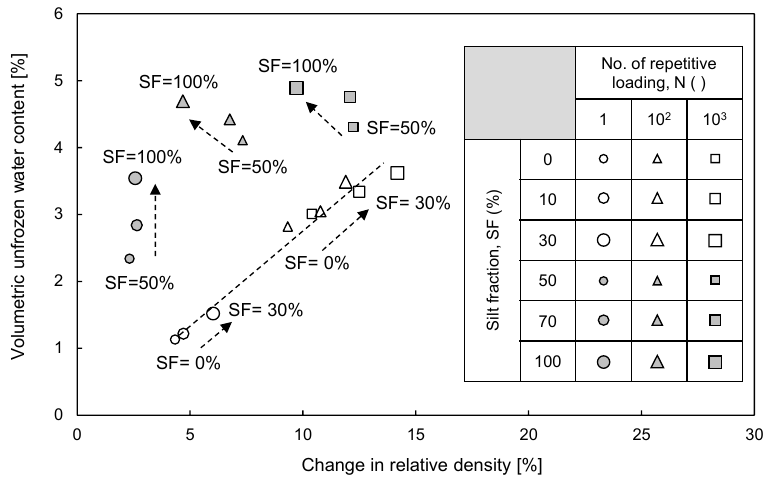
Figure 12. Relationship between volumetric unfrozen water content and change in relative density of sand–silt mixtures.